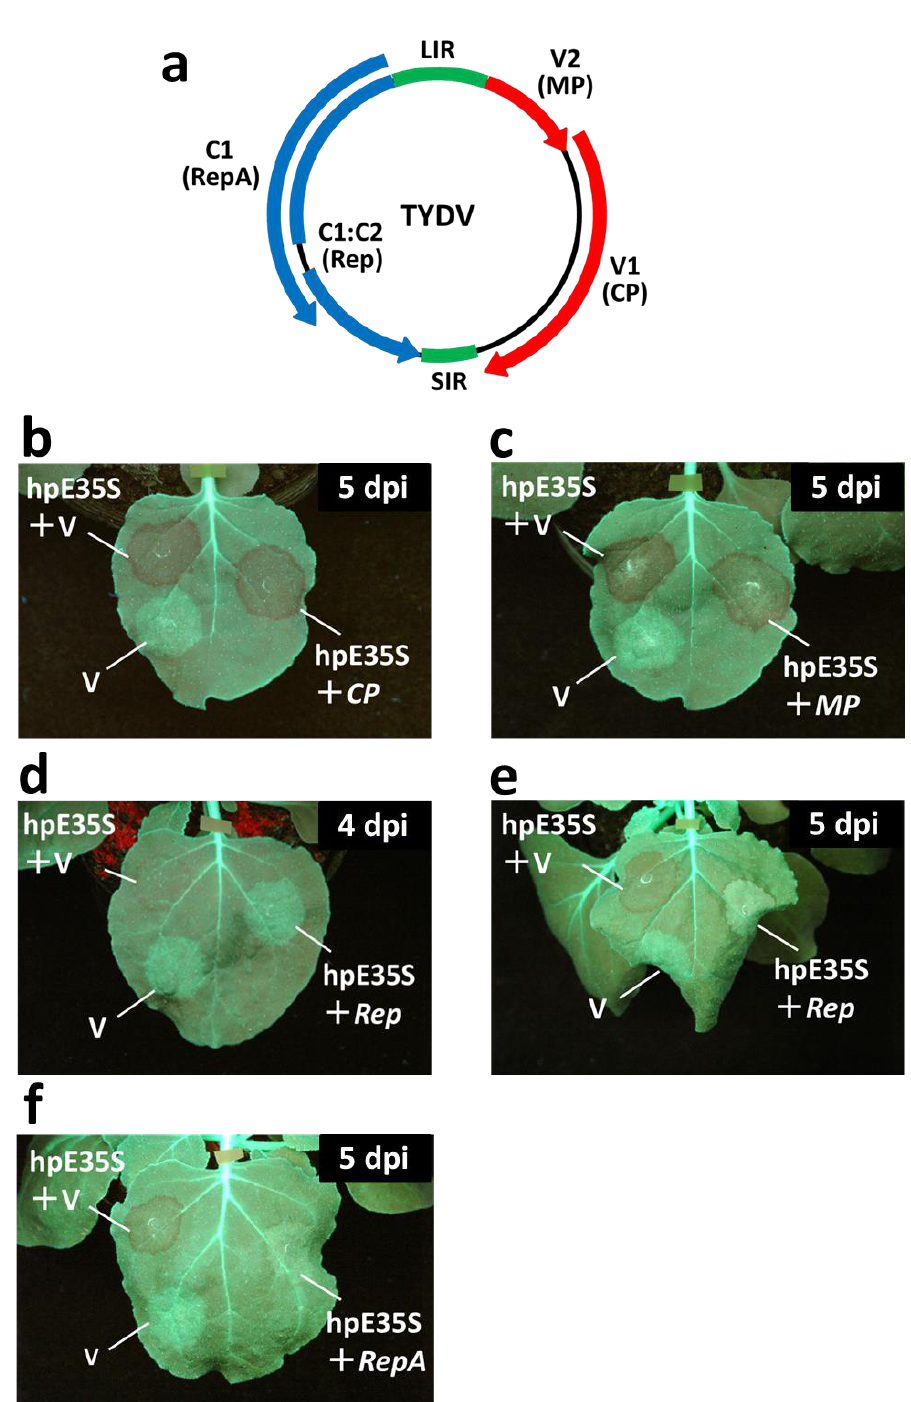
Figure 1. ( a ) Genome organization of Tobacco yellow dwarf virus . The large intergenic region (LIR) contains the origin of virion-strand replication and the bidirectional promoter regulating the expression of both virion-sense and complementary-sense genes. The small intergenic region (SIR) contains the origin of complementary-strand replication and the termination signals of the transcripts. ( b – e ) RNA-silencing suppression activity of genes from TYDV genome expressed in Nicotiana benthamiana line 16C plants. Leaves of line 16C were infiltrated with empty vector (V) or co-infiltrated with a mixture of two Agrobacterium transformants, one harboring hpE35S, and the other harboring either CP ( b ), MP ( c ), Rep ( d , e ), or RepA ( f ). Representative leaves were photographed under ultraviolet illumination at 5 days post-infiltration.